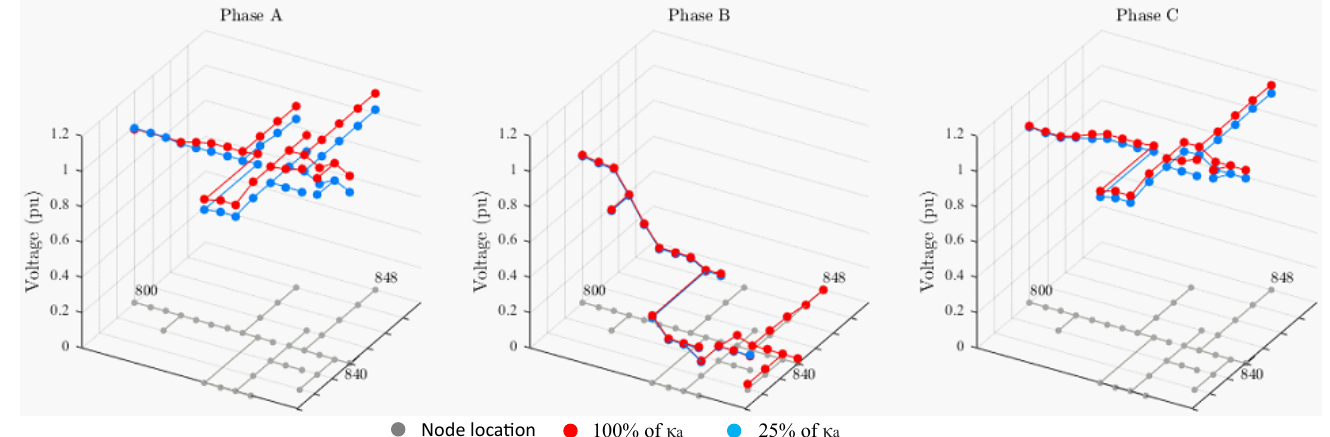
Figure 12. Voltage profile using the proposed method for single-phase fault in phase B.